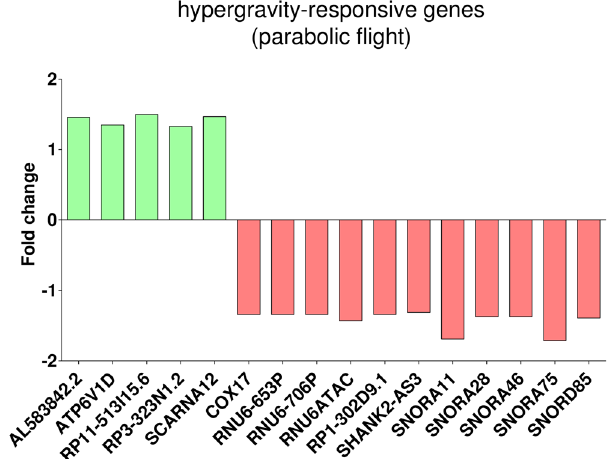
Figure 4. Hypergravity-responsive gene expression (parabolic flight). Exposure of Jurkat T cells to 20 s of hypergravity during the 23 rd DLR parabolic flight campaign led to five up and eleven down-regulated genes when compared to the 1 g in-flight control (log2 values, p < 0.05).